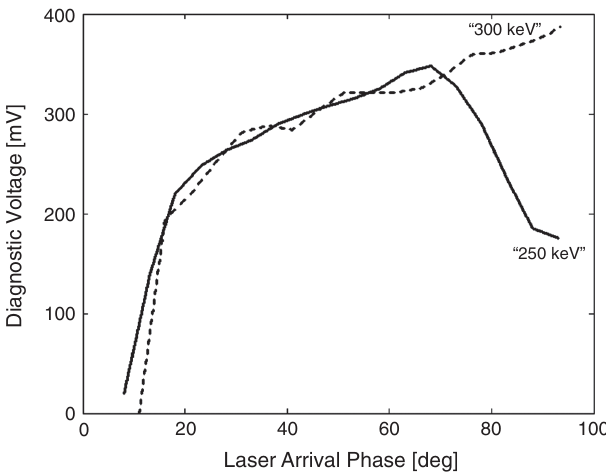
FIG. 19. Diagnostic voltage as a function of laser arrival phase at the cathode, for beams with two nominal energies. The diagnostic was not calibrated during this test, but diagnostic voltage scales with bunch charge. The beam energies are nomi- nal only, since adjusting the launch phase of the electron bunch will affect its energy significantly.